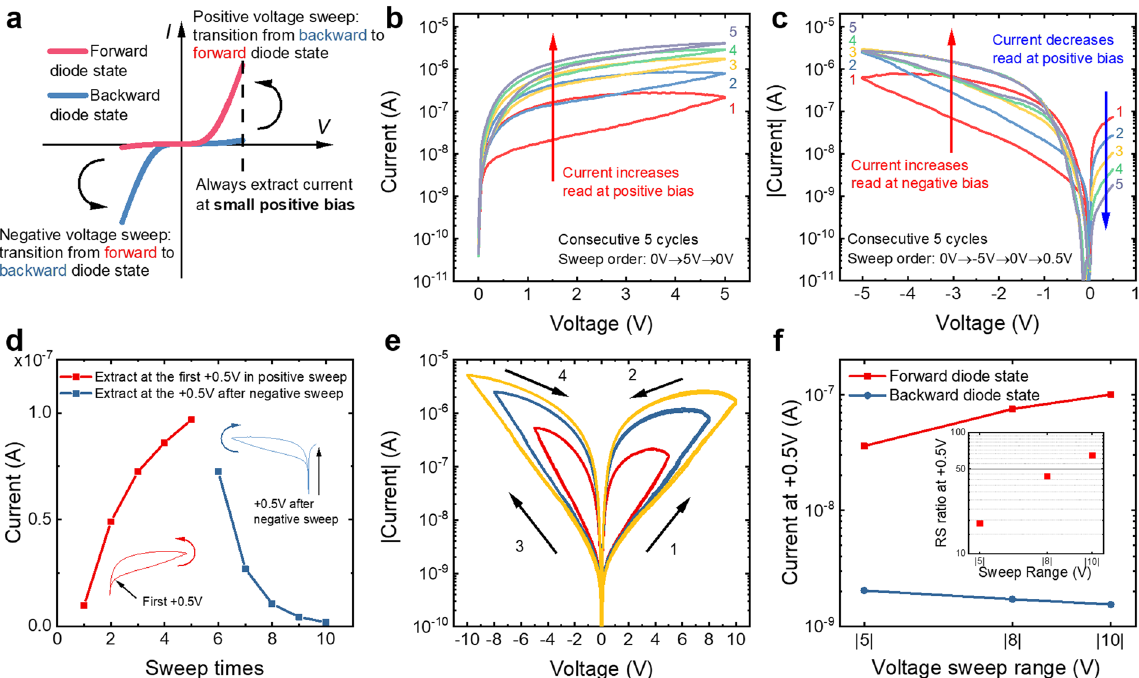
Fig. 4 DC characteristics of ReS 2 memristors. a Schematic of I – V curve in linear scale. The black curved arrow in positive regime refers to the transition from backward diode state to forward diode state, and the black curved arrow in negative regime means the transition from forward diode state to backward diode state. b I – V curves of fi ve consecutive positive voltage sweeps (0 → + 5 → 0 V). Current increases with the sweep cycle number. c I – V curves of another fi ve cycles of sweep (0 → − 5 → 0 V). Current increases in negative regime and decreases in positive regime. d DC-programmed potentiation and depression. The red dots are extracted from the fi rst + 0.5 V in different cycle sweep in b and blue dots are extracted at + 0.5 V in different cycle sweep in c . Insets are schematics showing the extraction of current values at the same base voltage of + 0.5 V. e I – V curves measured under different voltage sweep ranges. The curves shown here are not measured consecutively. f Extracted current value at + 0.5 V under different sweep ranges. Inset shows that the calculated RS ratio increases with voltage sweep curves 45 , which is larger than 5 ( I ~ V k and k ≥ 5) as shown in Fig. 5b. Details of transition voltage extraction are described in Supplementary Fig. 11. The variation and histogram of B – F and F – B transistion voltages are depicted in Fig. 5b and c, respectively.